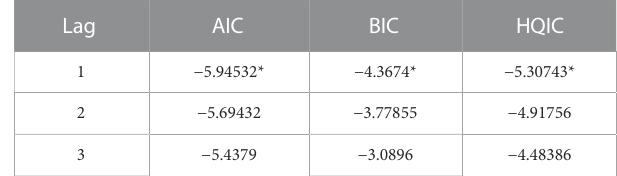
TABLE 4 Test results of optimal lag order selection.